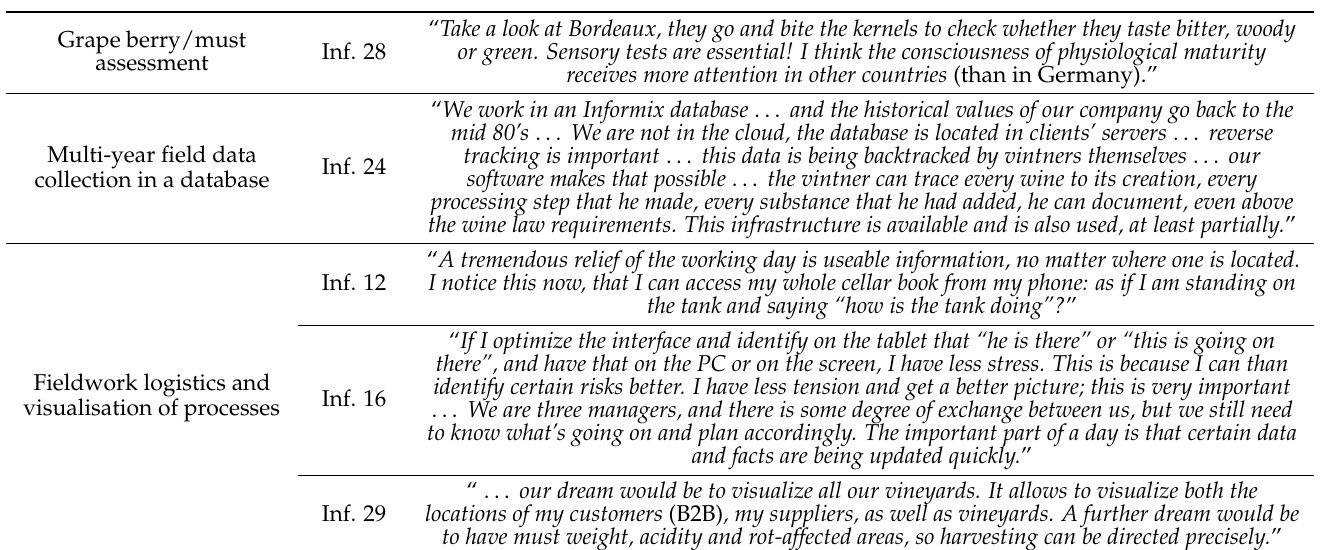
Table 1. Verbatim codes for types of new technologies deployed in SMEs.